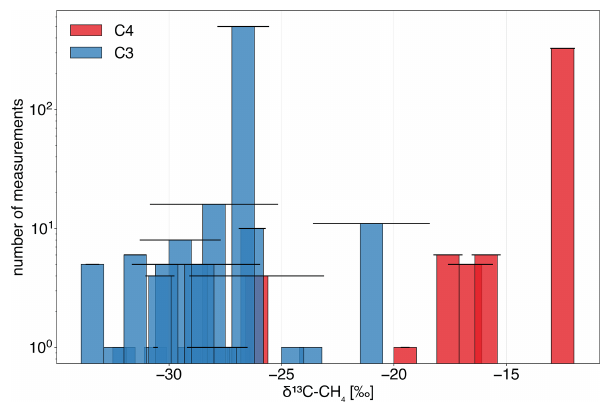
signatures from biomass burning Figure A3. Measured δ 13 C CH 4 in literature studies (Stevens and Engelkemeir, 1988; Wahlen et al., 1989; Levin et al., 1993; Chanton et al., 2000; Snover et al., 2000; Fisher et al., 2011; Umezawa et al., 2011; Brownlow et al., 2017) according to the type of vegetation: a majority of C 3 plants (blue) or C 4 plants (red). Bar heights represent the number of measurements and black lines standard